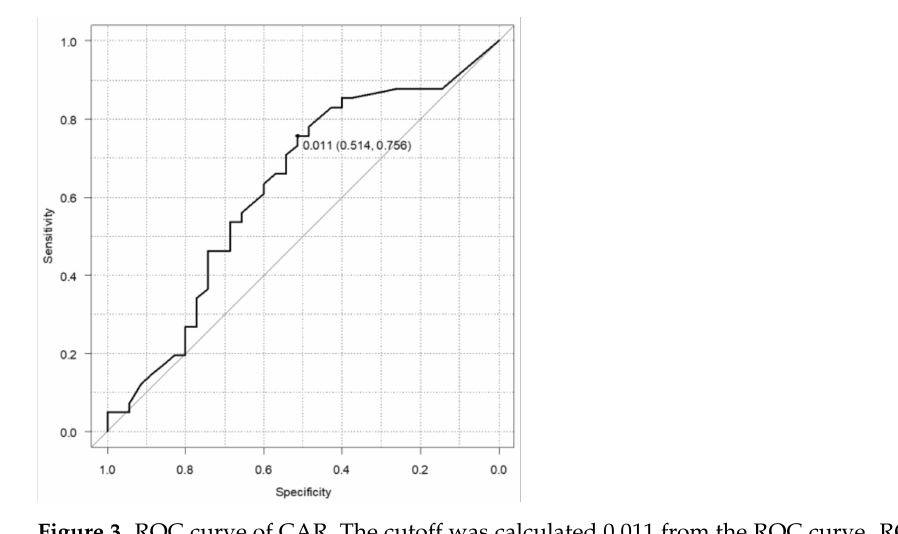
Figure 3. ROC curve of CAR. The cutoff was calculated 0.011 from the ROC curve. ROC: receiver operating characteristic, CAR: C-reactive protein albumin ratio.